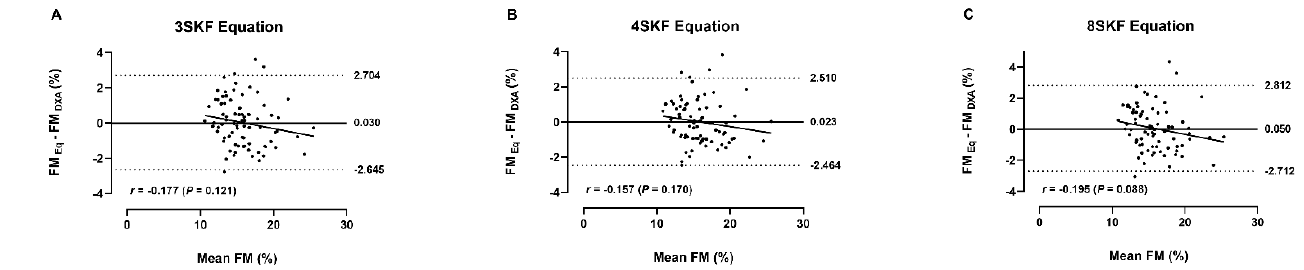
Figure 2. The Bland–Altman plots between the fat mass percentage differences and means of the reference method (FM DXA (%)) and the novel prediction equations (FM Eq (%)) in high-level male futsal players ( n = 78). The solid line represents the mean difference (fixed bias), the dotted lines indicate the 95% limits of agreement ( ± 1.96 SD) and trend illustrates the correlation ( r ) between the difference of the methods and the mean of the methods (proportional bias). The prediction equations are ( A ) the sum of three skinfolds (triceps, abdominal, and front thigh), waist girth; ( B ) the sum of four skinfolds (triceps, iliac crest, abdominal, and front thigh), waist girth; ( C ) the sum of eight skinfolds (triceps, subscapular, biceps, iliac crest, supraspinale, abdominal, front thigh, and medial calf), waist girth. No significant correlations between the difference and the mean of the methods (all p > 0.05).